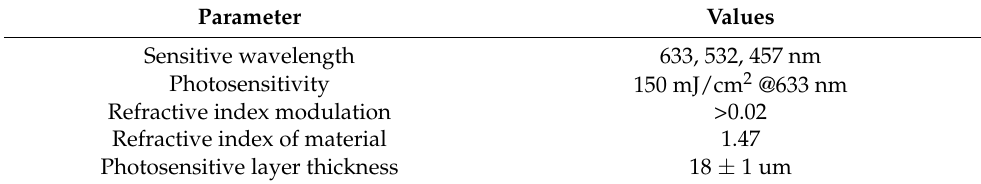
Table 2. The parameters of the printing HOE. Parameter Values